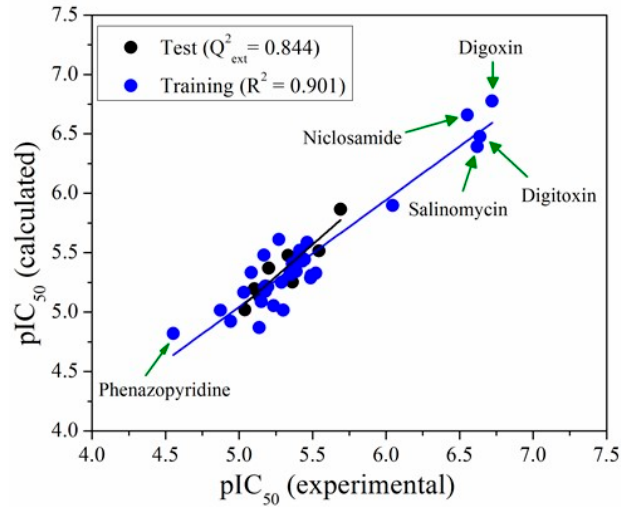
Figure 4. Experimental vs. calculated pIC 50 values by the model M13.